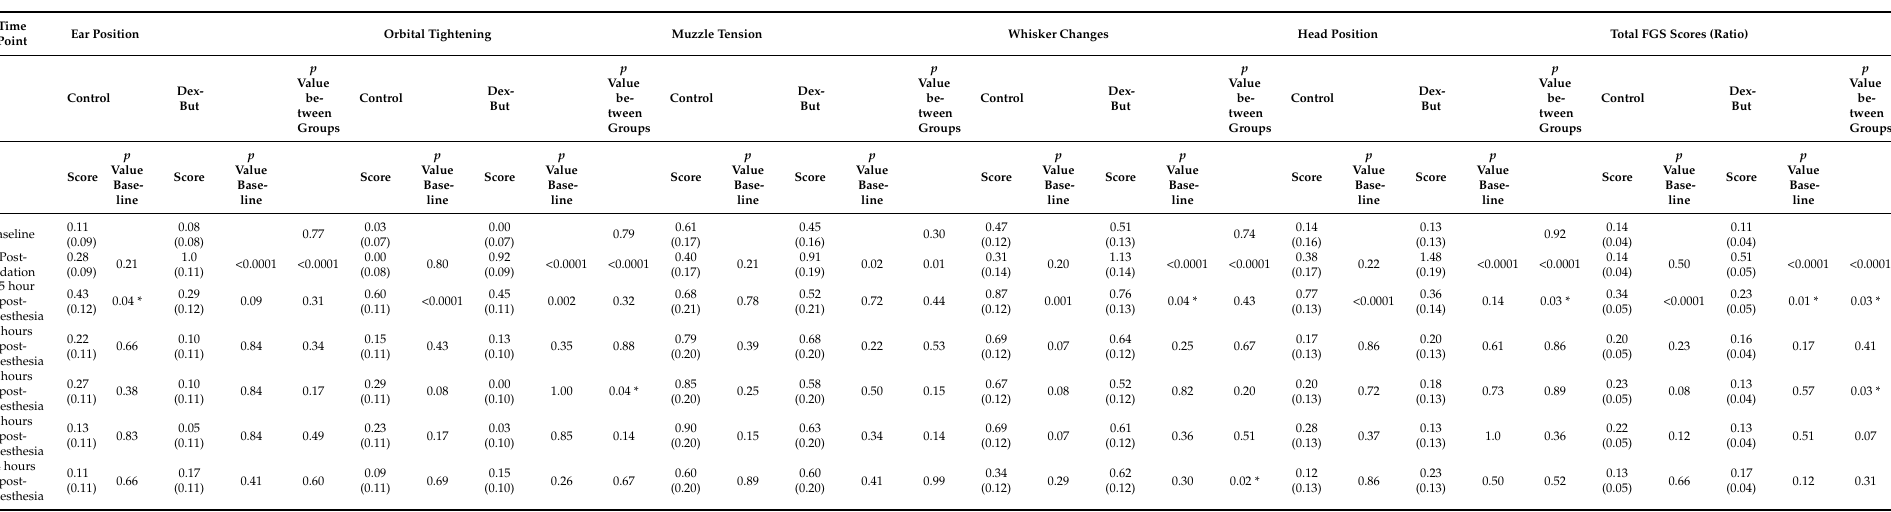
Table 2. Mean (Standard Error) of Feline Grimace Scale © scores in healthy cats before and after treatment with saline or dexmedetomidine and butorphanol (Dex-But), and general anesthesia with propofol and isoflurane. Data were analyzed using linear mixed models for repeated measures. The p values are presented for comparisons between groups and within groups (each time point and baseline). Significant values are presented in bold. * indicates p values not statistically significant after adjustment using the Benjamini–Hochberg